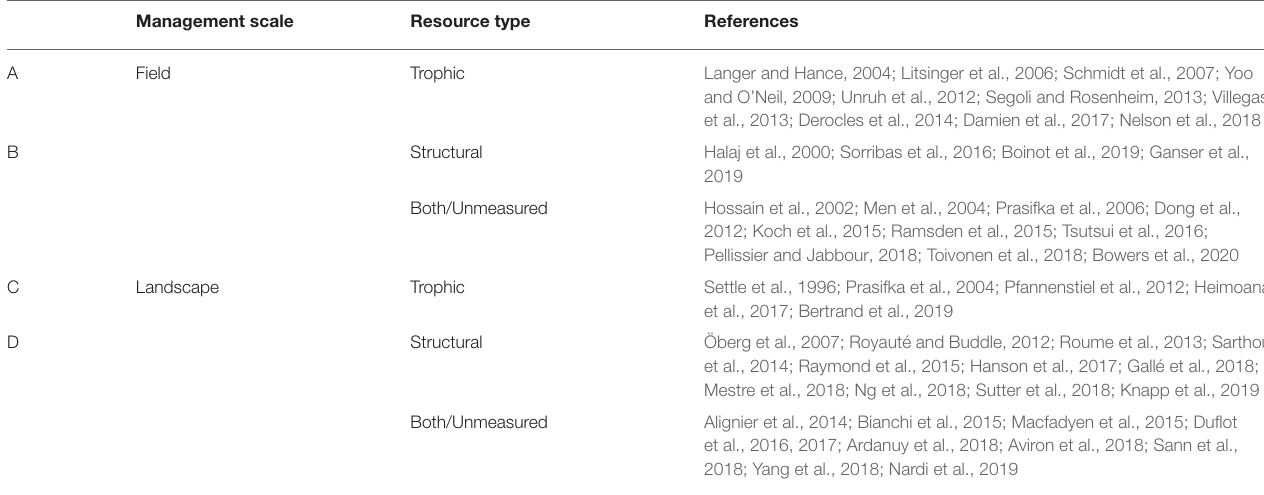
Letters correspond to arrows in Figure 2